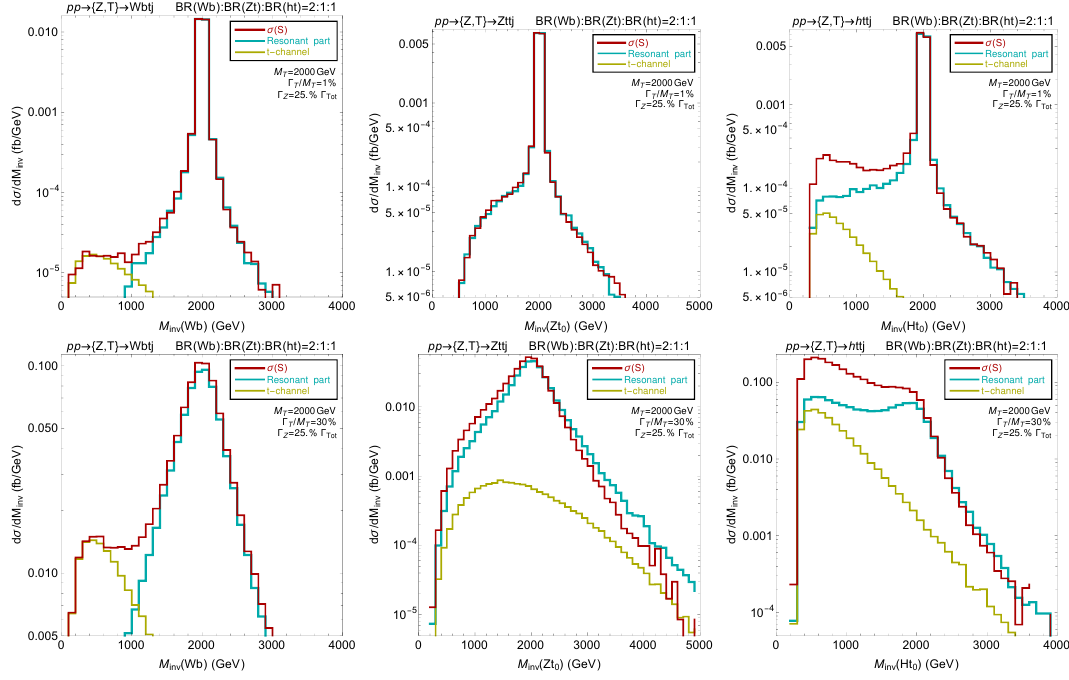
Figure 21 . Same as figure 20 for M T = 2